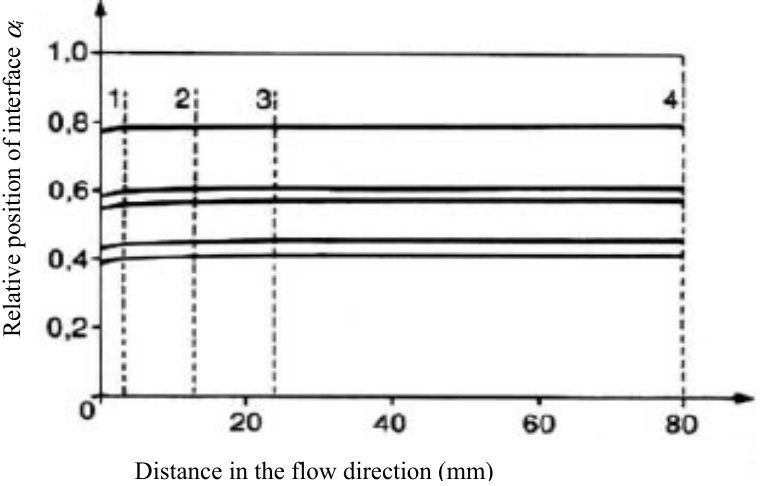
Figure 16. Variation of the interface positions along the coextrusion flow (Reprinted from Ref. [15]).